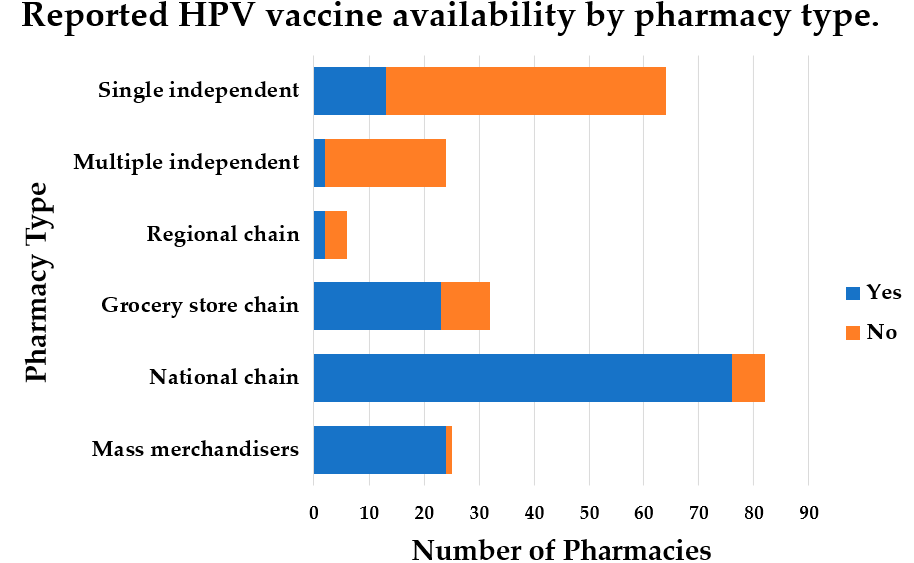
Figure 1. Reported HPV vaccine availability by pharmacy type. The total number of pharmacies, stratified by type, is indicated by each bar. Each bar is stacked to display the proportion of pharmacies, within that pharmacy type, that have the HPV vaccine available and those that do not have the HPV vaccine available. Chi-squared analysis revealed a significant difference in HPV vaccine avail- ability across pharmacy type ( p < 0.001).